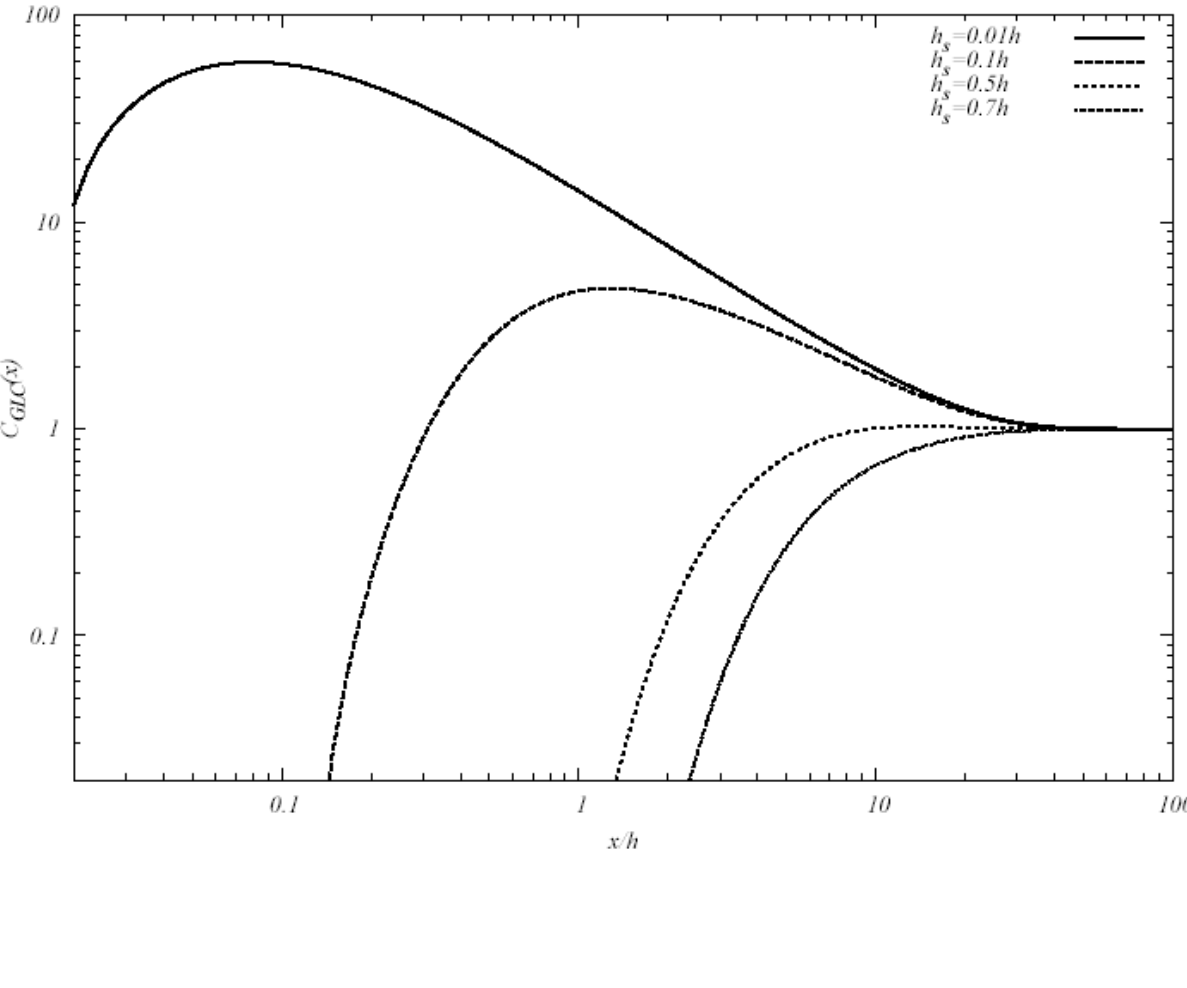
Figure 1. GILTT (Generalized Integral Laplace Transform Technique) Ground Level Concentration (GLC) versus the horizontal distance from the source hxx different source heights are selected: GLC occurs only for sources below the Atmospheric Boundary Layer (ABL) middle